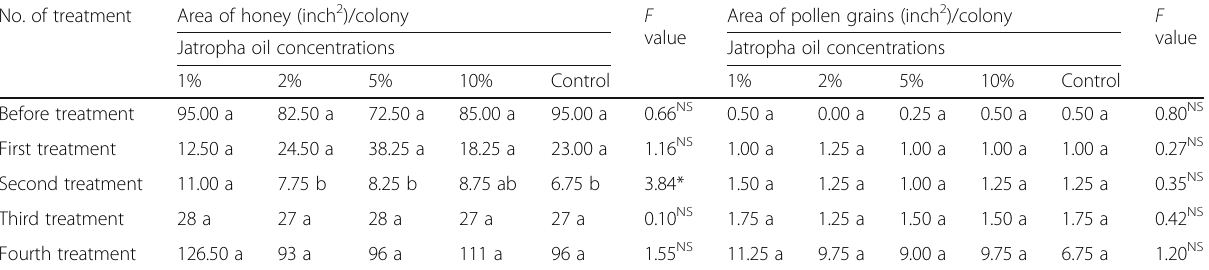
Table 5 Effect of different concentrations of jatropha oil extract on the honey and pollen grains stored in the tested honeybee